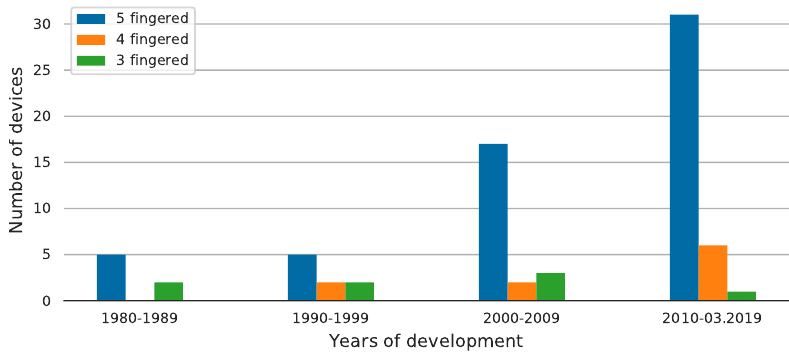
Figure 3. Timeline of number of fingers in robotic